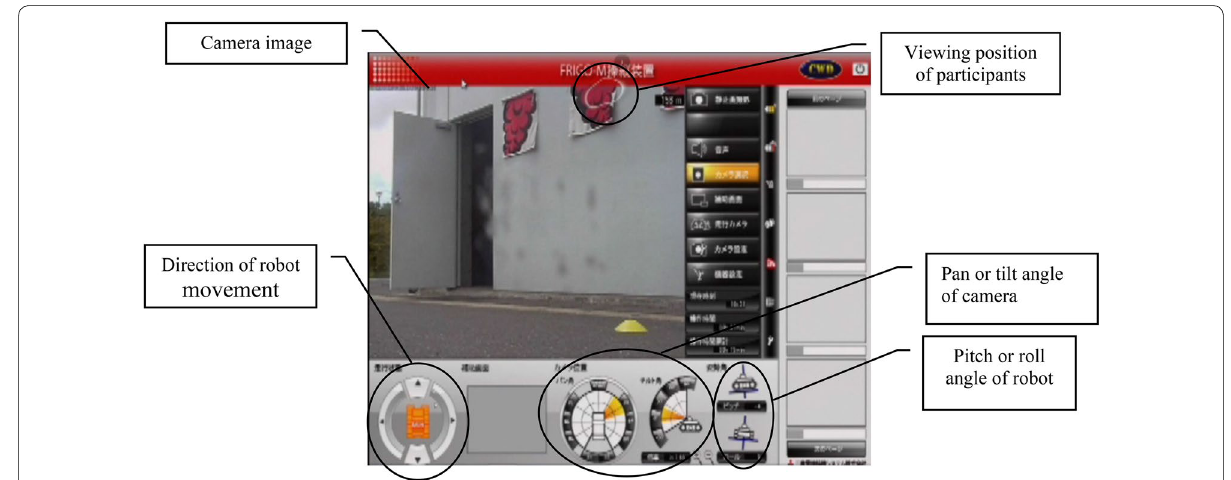
Fig. 7 Operating monitor during